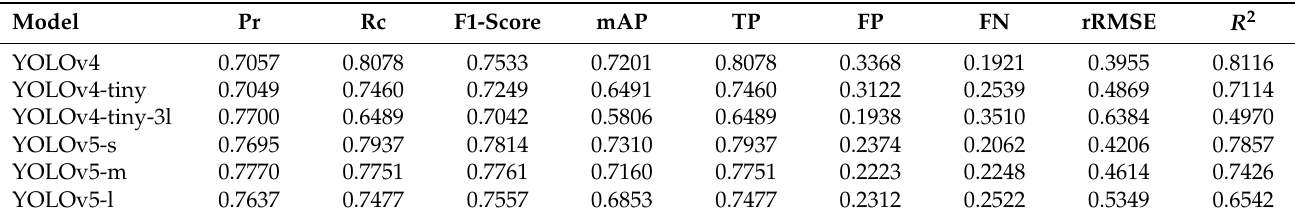
Table 8. Results for each model obtained in the evaluation